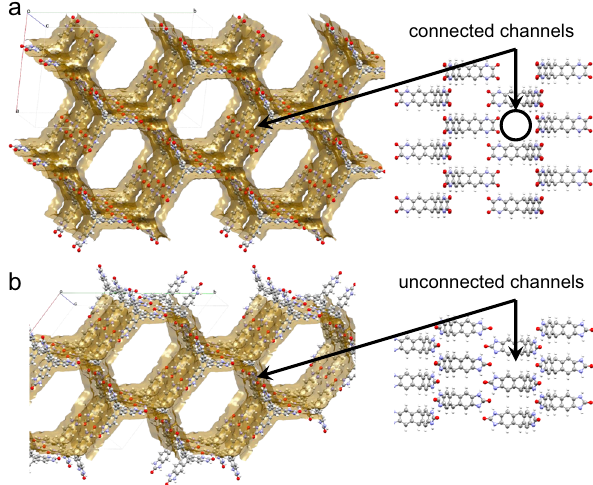
Fig. 4 ESF maps predict a highly porous solid for TH5. Solvent accessible surfaces (left) of TH5-A ( a ) and T2- γ ( b ). TH5-A shows a three- dimensionally interconnected pore space within the structure. Unlike for T2- γ , the 1D hexagonal pore channels in TH5-A are predicted to be connected by apertures in the pore walls that are orthogonal to the direction of the channels; one such aperture is indicated by the black circle on the right-hand-side fi gure. Predicted surface area for TH5-A